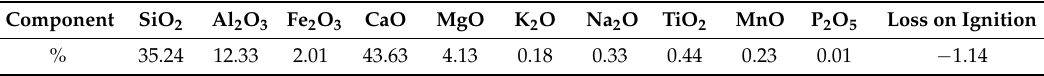
Table 1. These values were used as “reference values” for estimating the LCH. Rs of Si and other metal ions from the slag by AR treatment. Table 1. Concentrations of metal oxides (wt %) present in BFS by XRF analysis. Table 1. Concentrations of metal oxides (wt %) present in BFS by XRF analysis. Component Component SiO